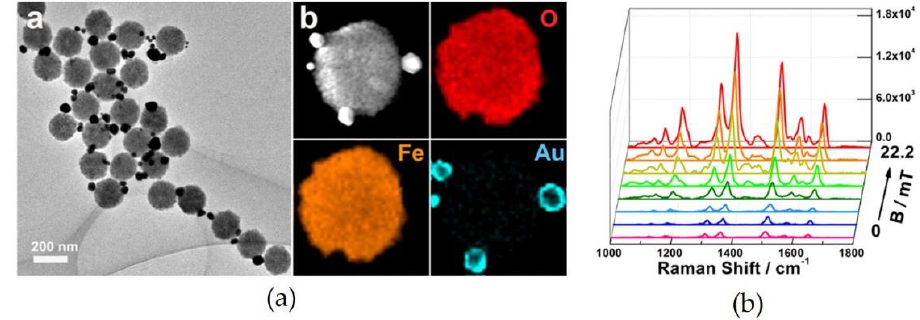
Figure 7. ( a ) TEM image and High-angle Annular Dark Field (HAADF)-STEM image of the Fe 3 O 4 @Au particles; and ( b ) Raman spectra of probe molecules (R6G) measured under the application of a magnetic field. Reproduced with permission from Reference [67] (Copyright 2014 Springer Nature).